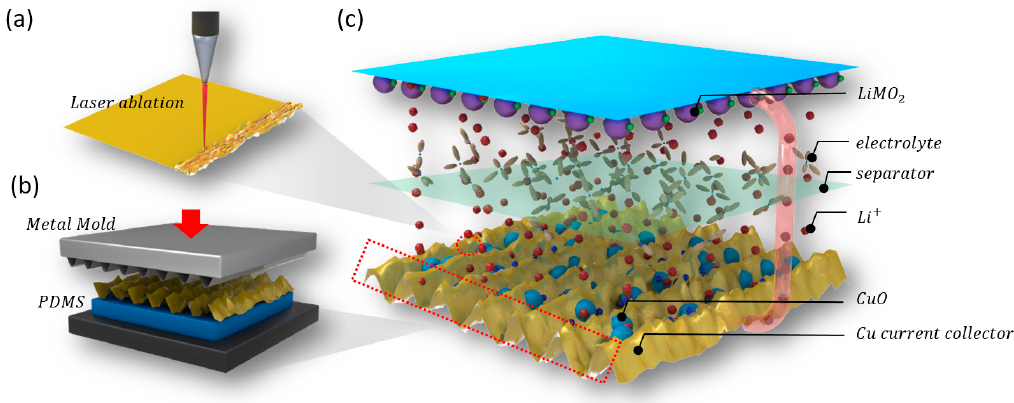
Figure 1. Fabrication of the hierarchically nanostructured CuO–Cu current collector: ( a ) CuO–Cu current collector with the nanostructure formed from the laser ablation on the Cu current collector; ( b ) imprinting method over the CuO–Cu current collector for the microstructure addition; ( c ) lithium-ion battery for which the hierarchically nanostructured CuO-Cu current collector was applied.